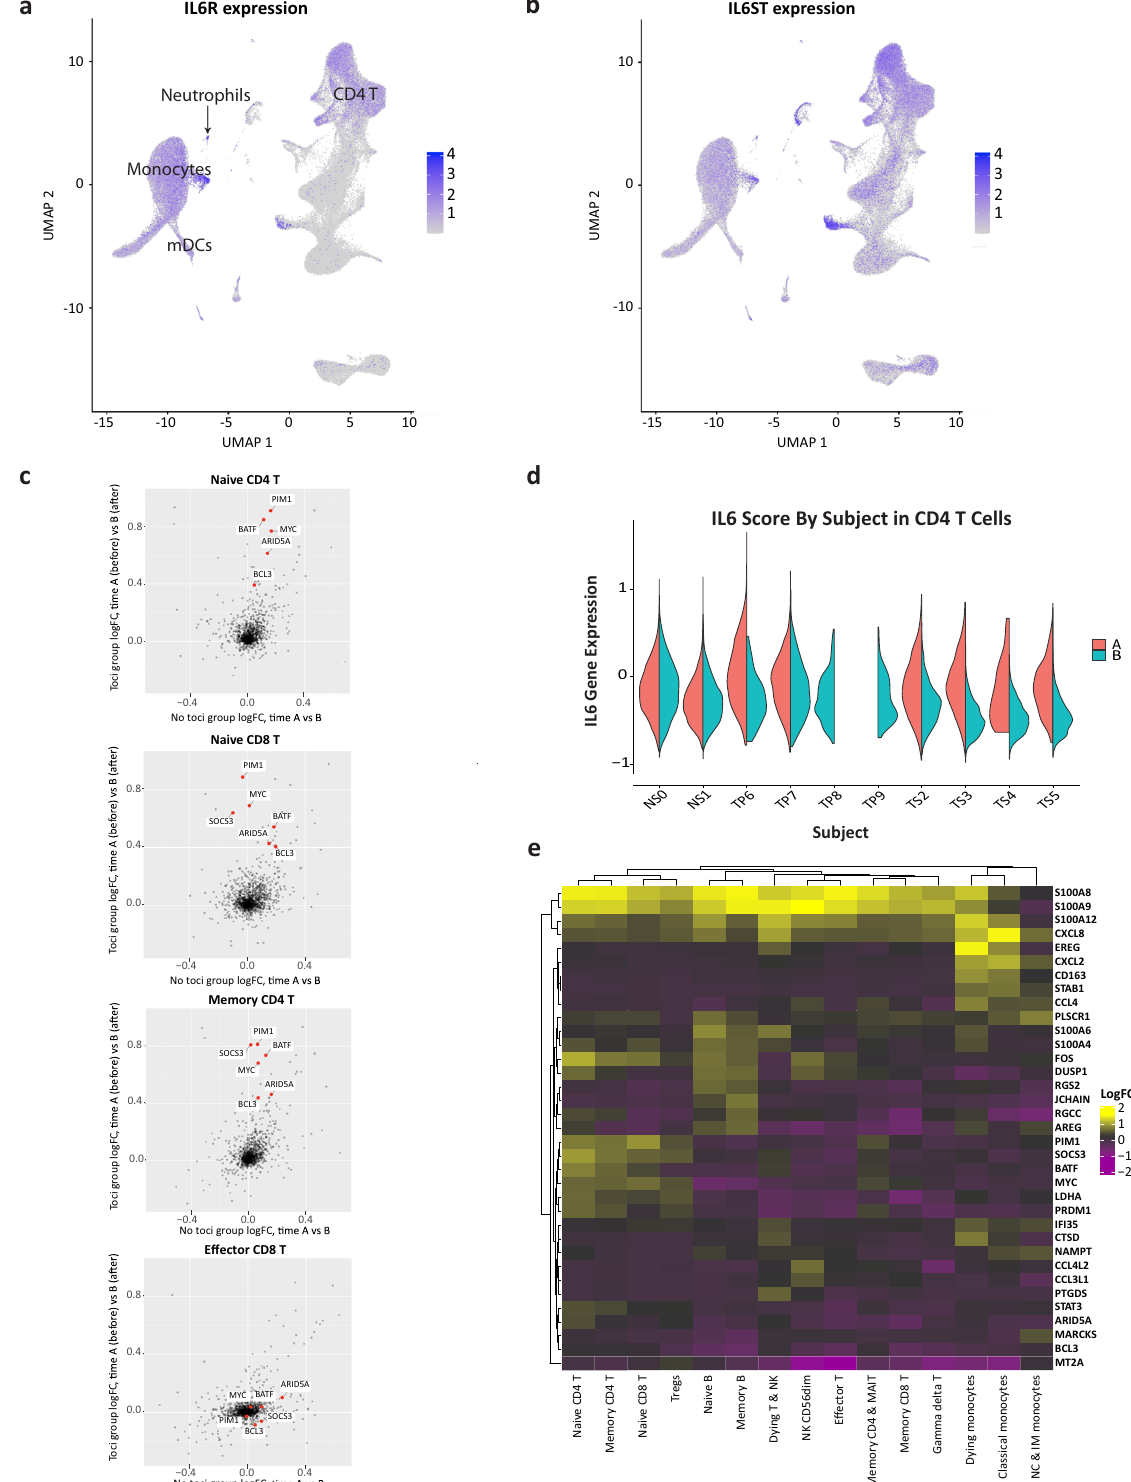
and memory and naive CD8 + T cells. The diversity of memory diversity was not observed in memory and naive CD4 T cells. The and naive CD8 + T cells at both time points showed lower change in CD4 + and CD8 + T cell clonal richness and evenness richness (Student ’ s t -test p -value = 0.045) and evenness (i.e., between time-point A and B were not signi fi cantly different Shannon index/richness, Student ’ s t -test p -value = 0.005) in between progressive and stable patients, possibly due to the small progressive patients than stable patients (Fig. 7c), which is number of progressive patients with data at both time points. consistent with the higher expansion of CD8 + T cell clones in (Fig. 7c, bottom panel). progressive patients (Fig. 7d) 16,40,71 . This difference in alpha NATURE COMMUNICATIONS| (2022) 13:440